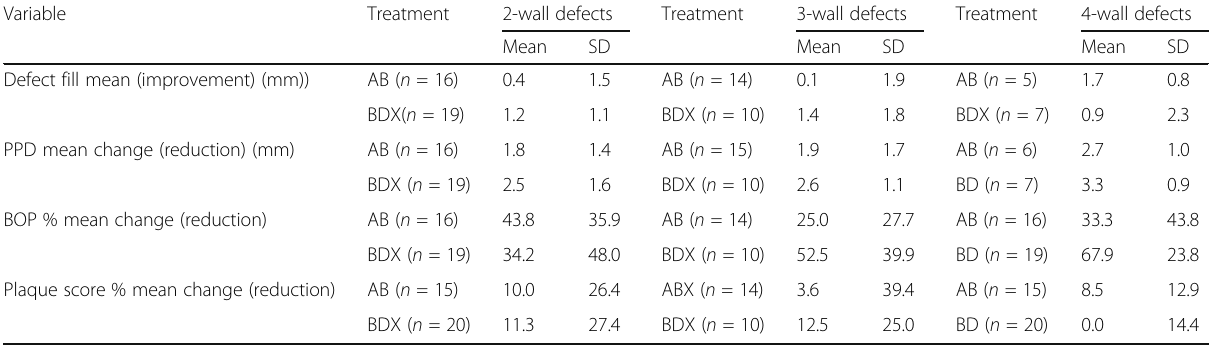
Table 3 Changes in clinical conditions between baseline and year one by defect configuration and treatment. Independent t tests (equal variance not assumed)) failed to demonstrate study group differences in clinical results regardless of defect configuration Variable Treatment 2-wall defects Treatment 3-wall defects Treatment 4-wall defects Mean SD Mean SD Mean SD Defect fill mean (improvement)